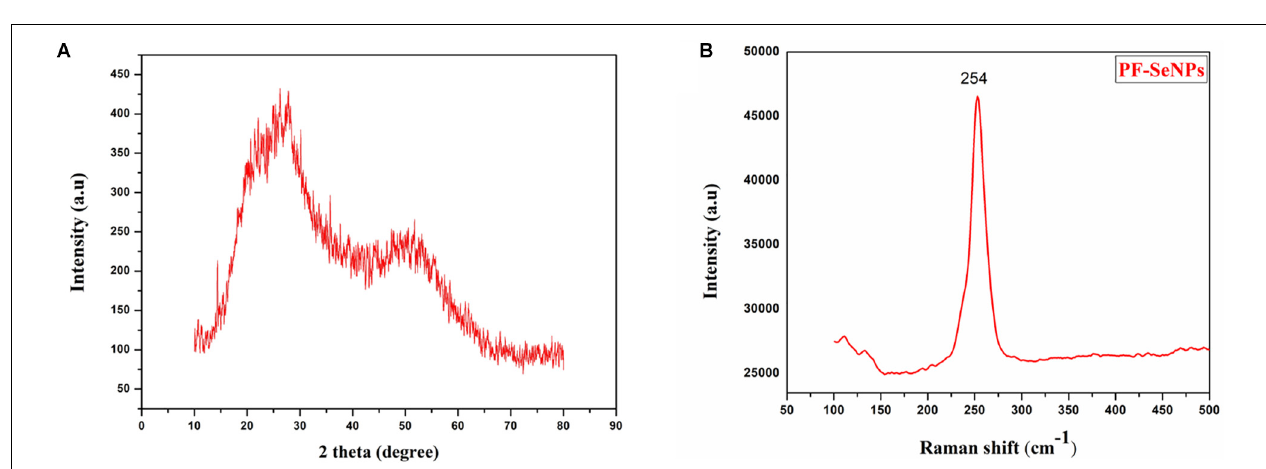
FIGURE 3 | Fourier transform infrared spectroscopy (FTIR) of aqueous fruit extract of E. officinalis and phytofabricated selenium nanoparticles (PF-SeNPs).